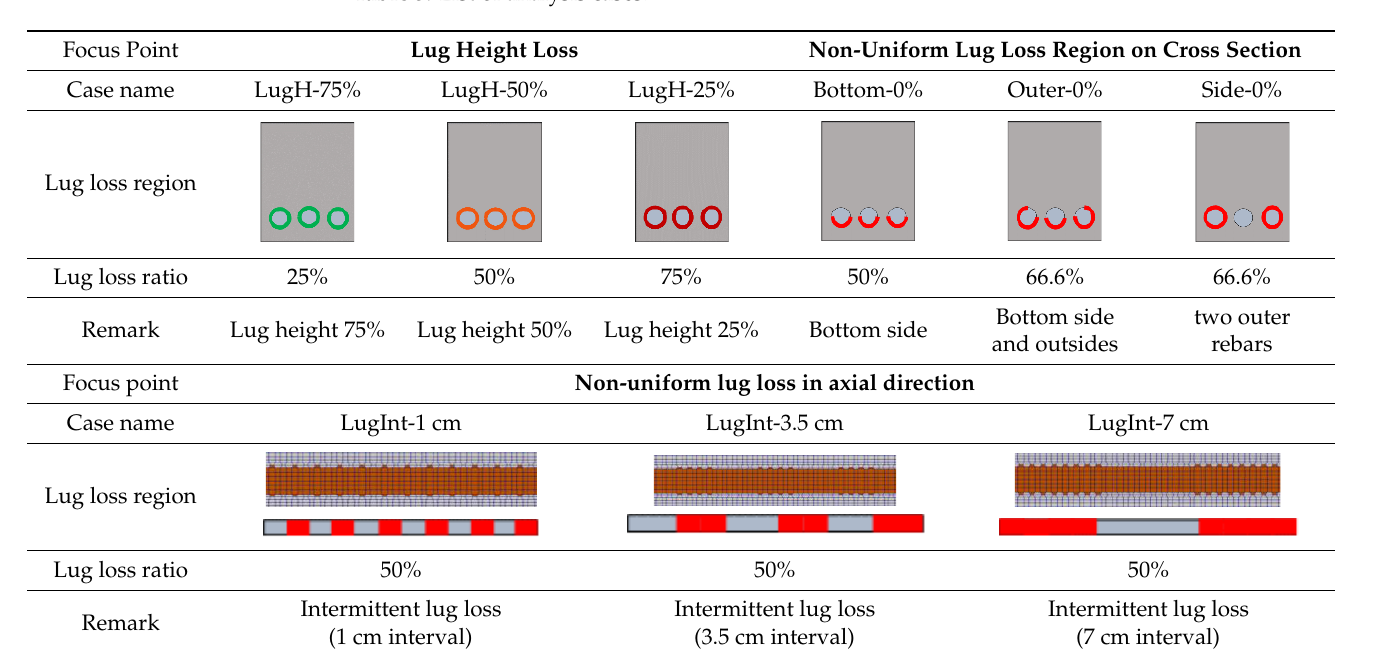
Table 5. List of analysis